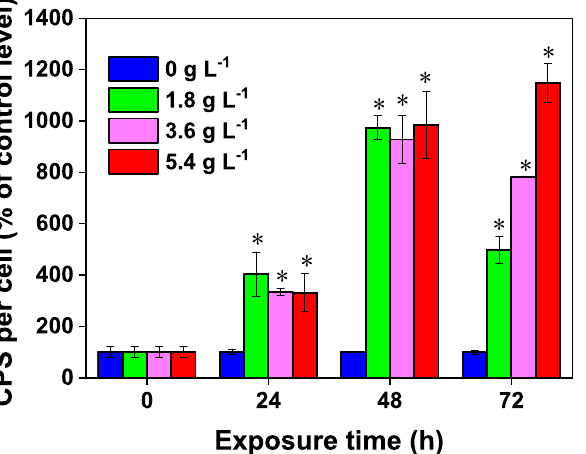
Figure 8. Capsular polysaccharide (CPS) levels in Dolichospermum flos-aquae treated with aqueous extract of watermelon peel (WMPAE) at different concentrations. (Data in the figure are shown as mean ± standard deviation for n = 3, *indicates p <